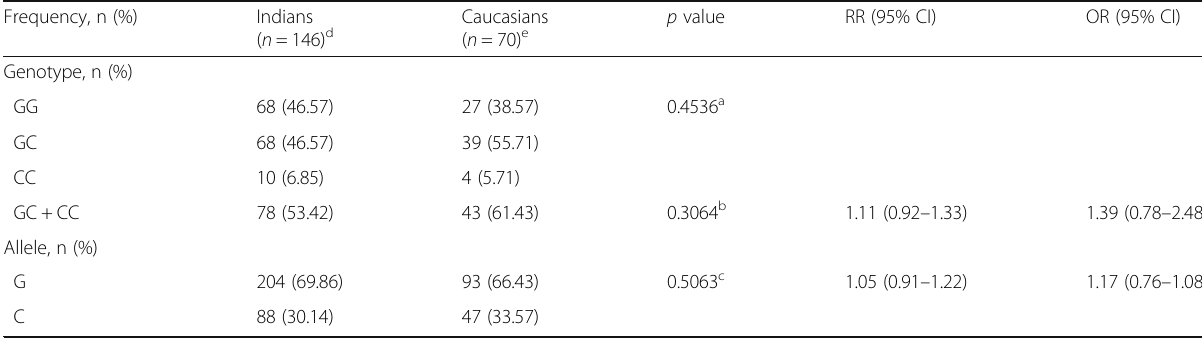
Table 2 Genotype and allele frequencies for all Indians and Caucasians (PsA patients + controls